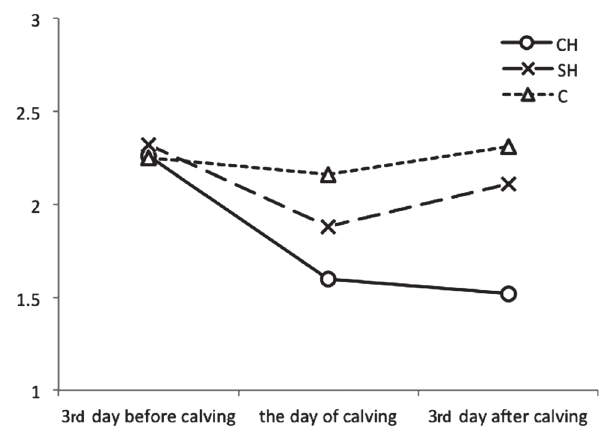
Figure 1. Ca concentration at three time points. The mean Ca concentration in each group at three time